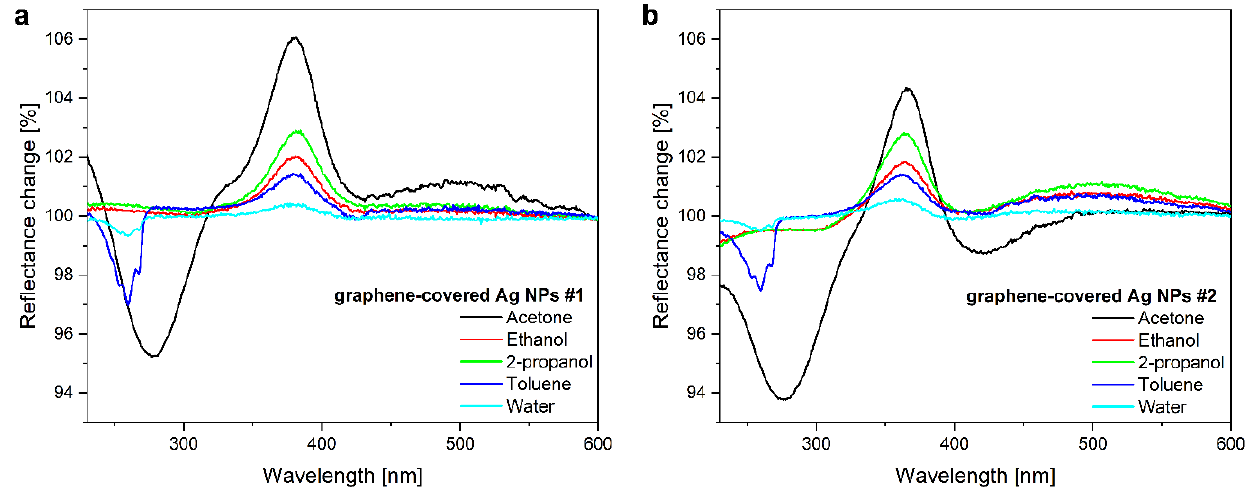
Figure 5. Reflectance change spectra of graphene-covered Ag NP samples when saturated vapors of acetone, ethanol, 2-propanol, toluene, or water are applied. The optical responses are substance- specific for both ( a ) as-prepared (#1) and ( b ) O 2 plasma-treated (#2) samples.